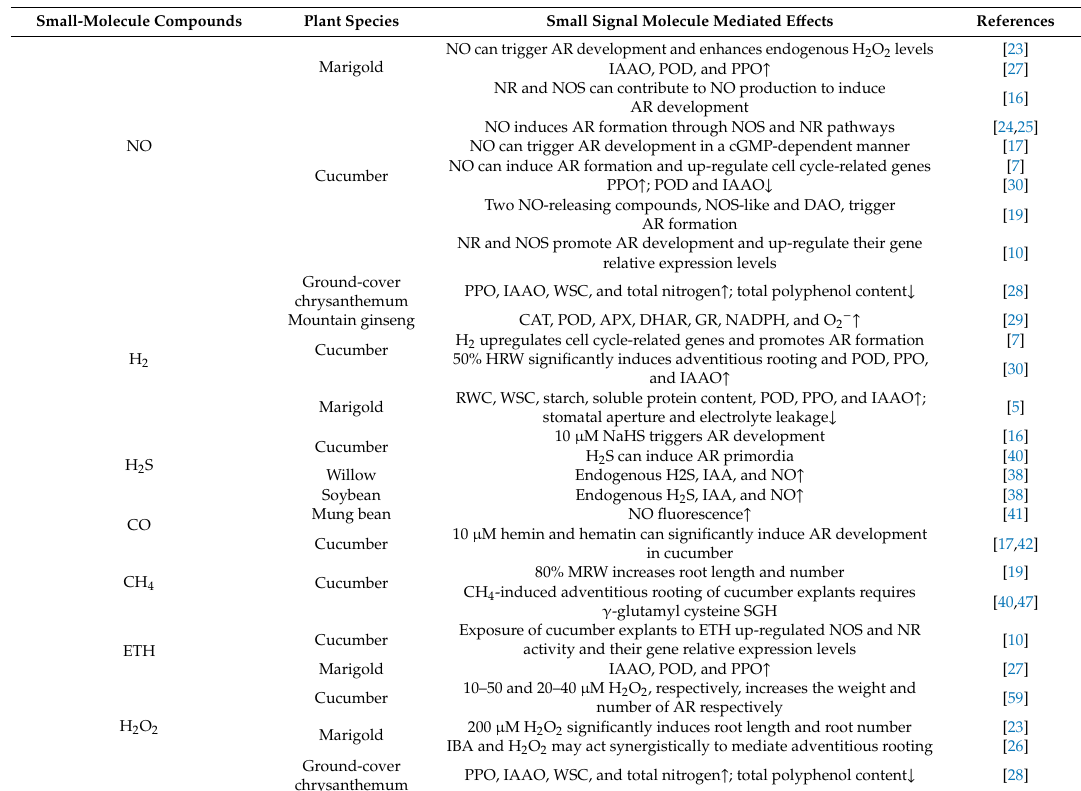
Table 1. Overview of small-molecule compounds that induce adventitious root (AR) formation and development under no stress in